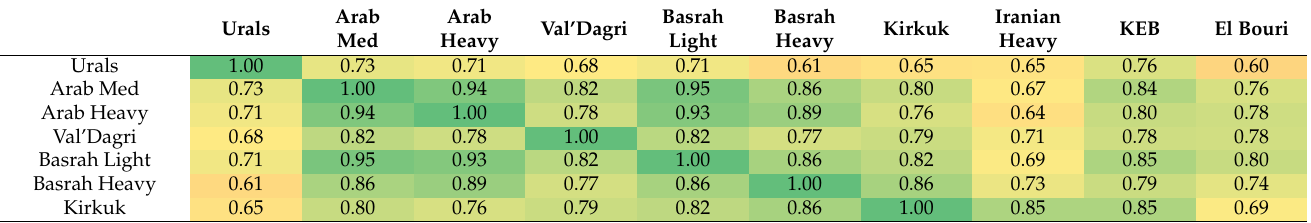
Note: Green color means a statistically meaningful positive relation; red color implies a statistically meaningful negative relation. The intensity of the color designates the strength of the relation: the higher the color intensity, the higher the strength of the relation. Yellow color denotes dissonance.